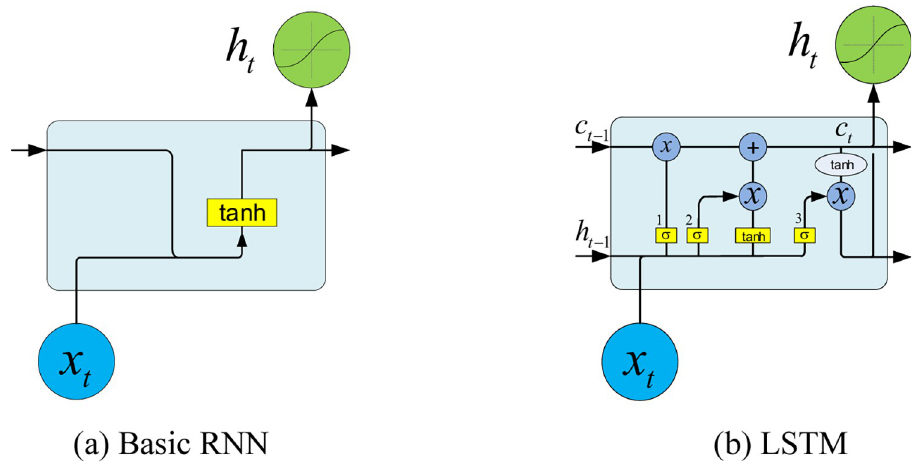
Fig 3. RNN models. (a) Basic RNN, (b)